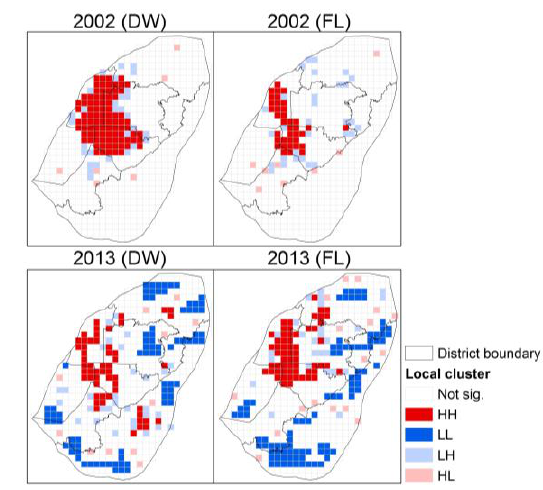
Figure 4. LISA cluster maps for DW and FL fires